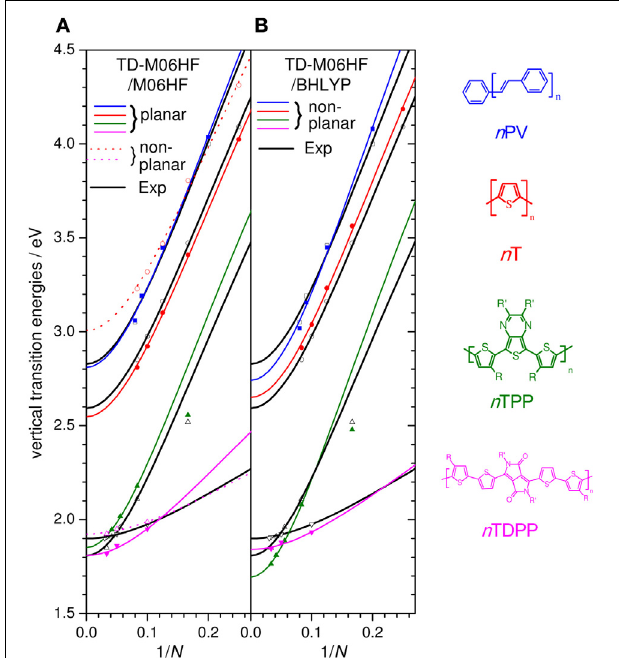
FIGURE 7 | Experimental E vert (black open symbols) and offset-corrected M06HF results for the n PV, n T, n TTP, and n TDPP series (R,R (cid:4) = alkyl chains) using; (A) planar M06HF geometries (solid symbols) and non-planar M06HF geometries (colored open symbols), both with (cid:2) E off = 0 . 75, and (B) non-planar BHLYP geometries using = 0 . 70. Lines are Kuhn fits to the data (cid:2) E off